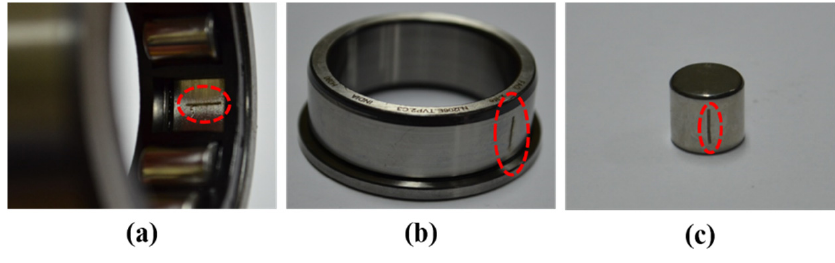
Figure 7. Fault types: ( a ) ORT, ( b ) IRT, and ( c ) RT.